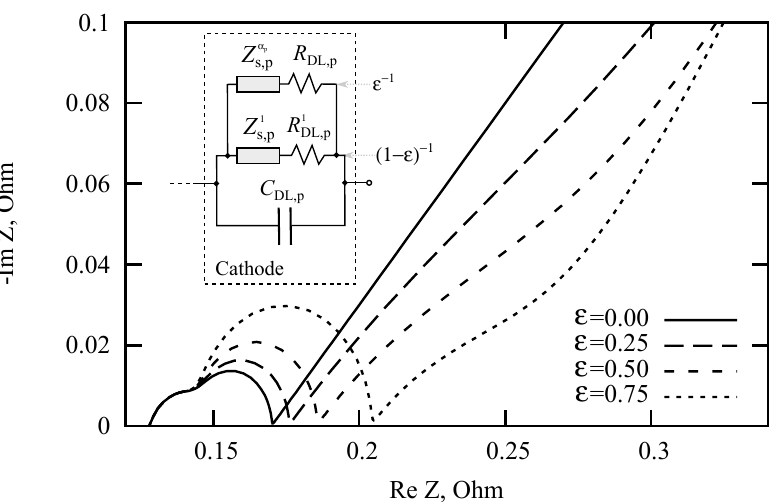
Figure 8. Nyquist diagrams for different values of the ε fraction of cathode particles characterized by ion subdiffusive transport. The 1 − ε fraction of particles is characterized by normal